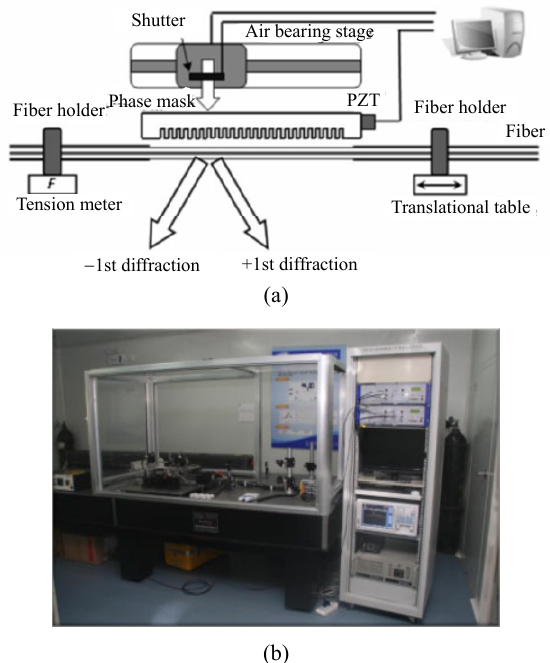
Fig. 7 Fabrication system of phase-shift grating using the phase mask: (a) structure diagram and (b)